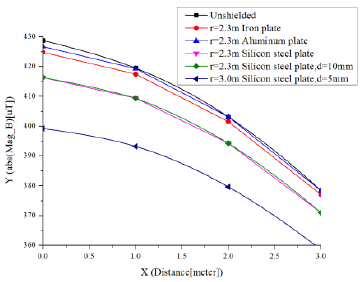
Figure 10. Shielding effect of different materials.